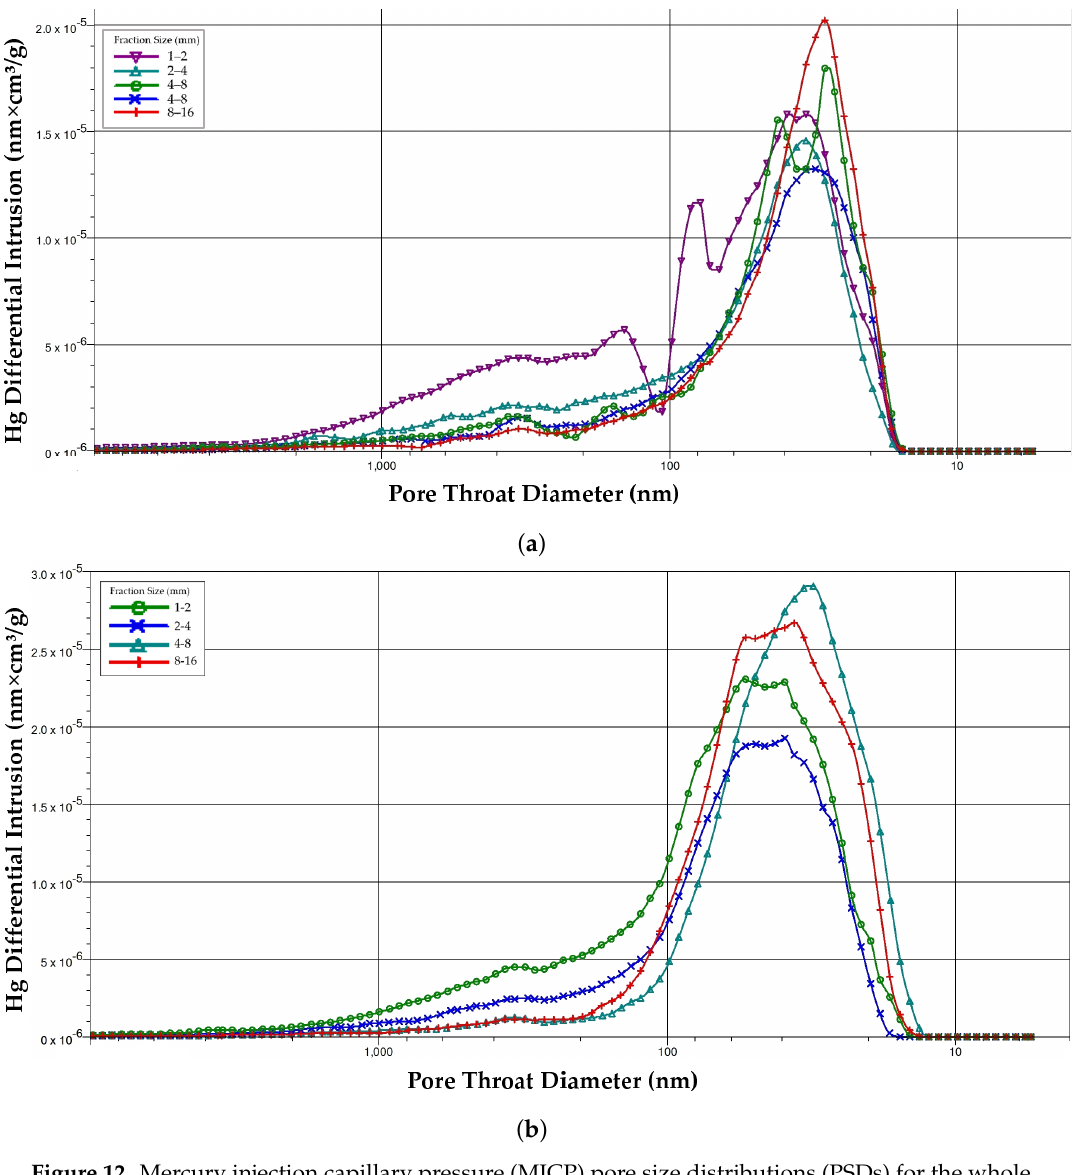
Figure 12. Mercury injection capillary pressure (MICP) pore size distributions (PSDs) for the whole core #545 depend on the rock fraction size ( a ) before and ( b ) after